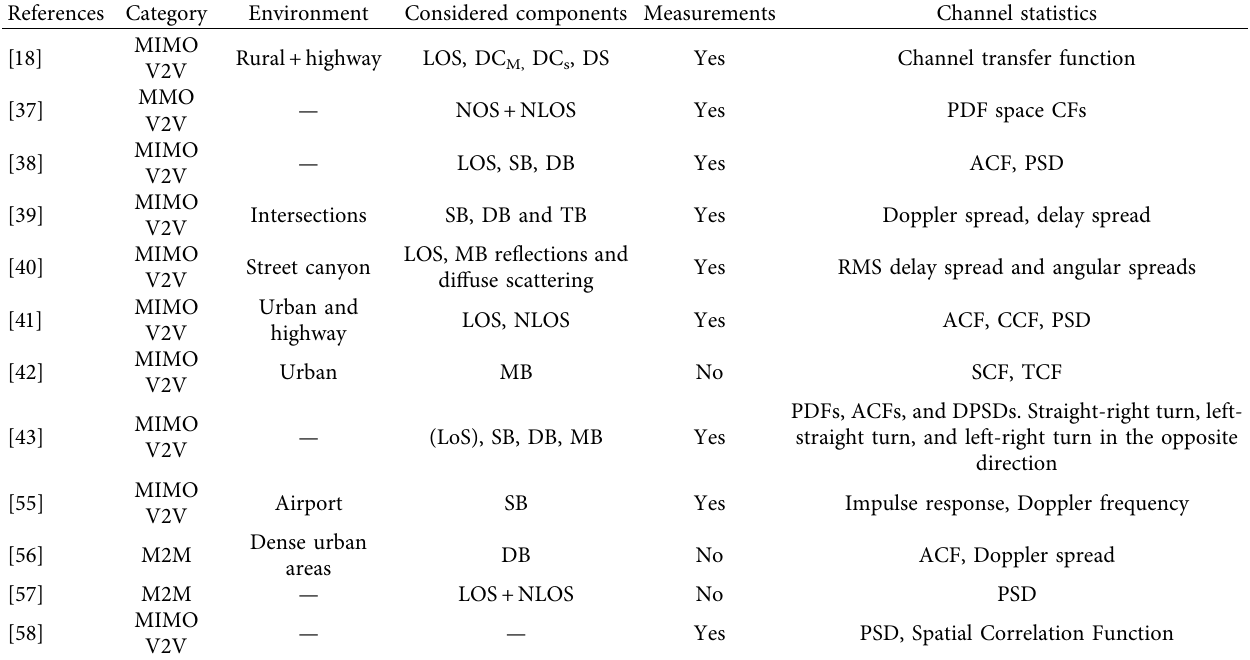
Table 2: IS-GBSM channel